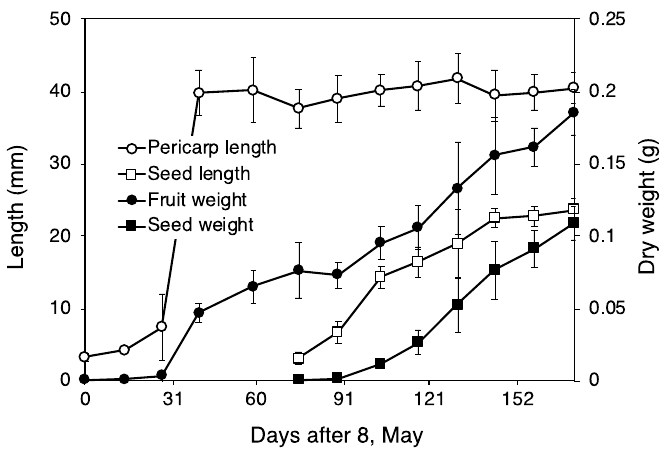
Figure 6. Fruit and seed development in Fraxinus platypoda . Bars indicate standard error.